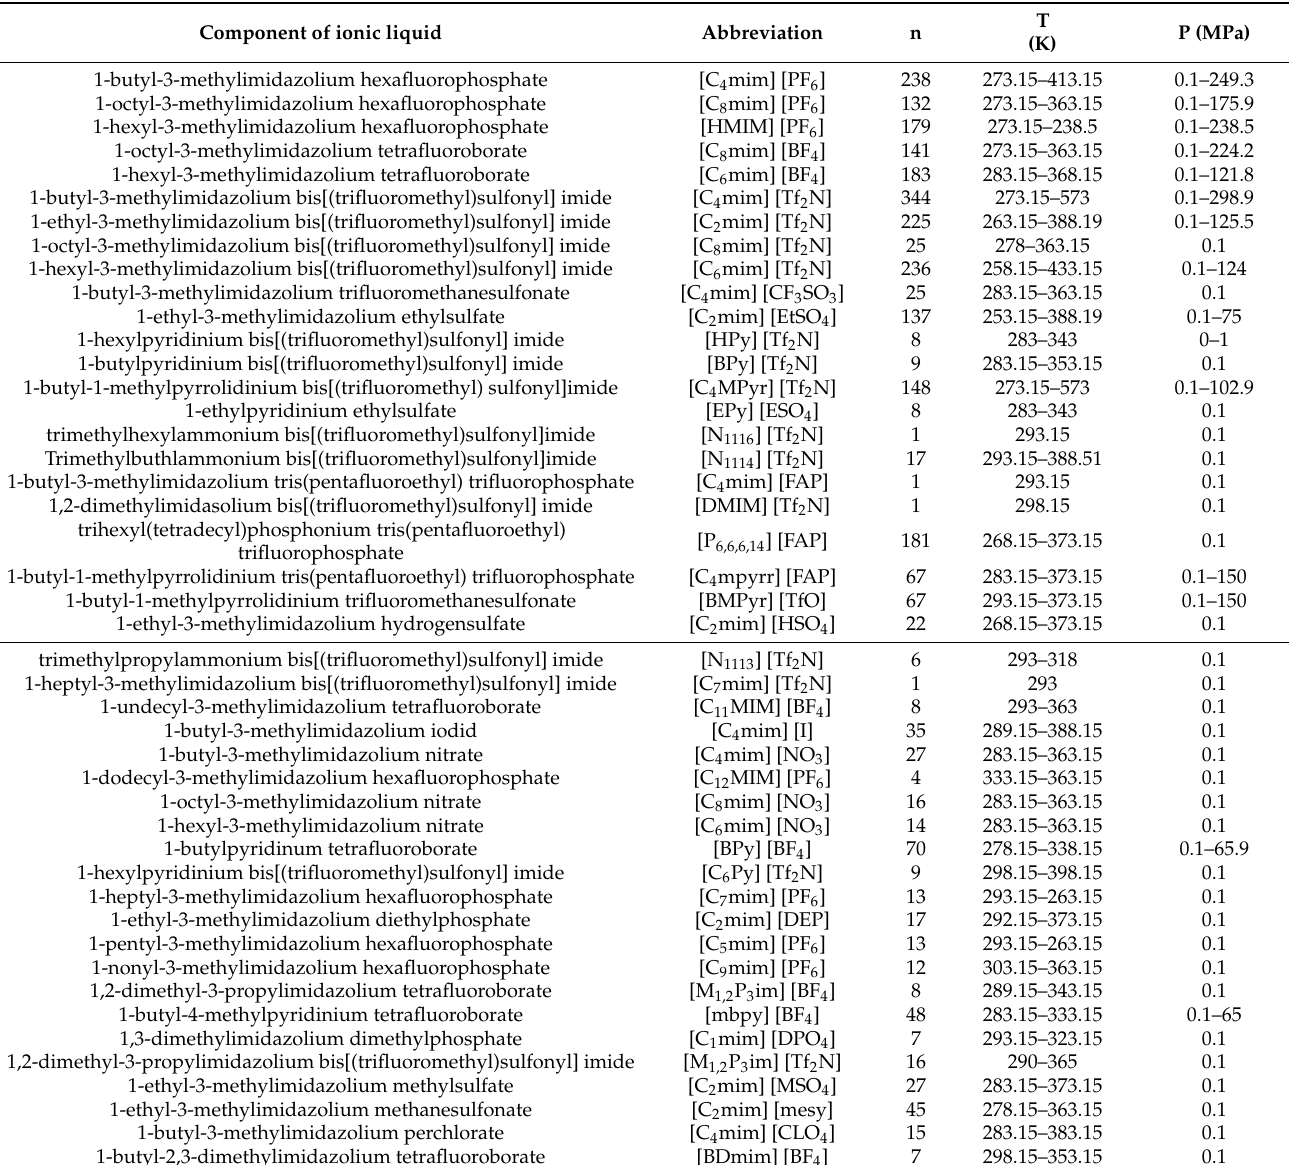
Table 1. The selected ionic liquids in the present study.